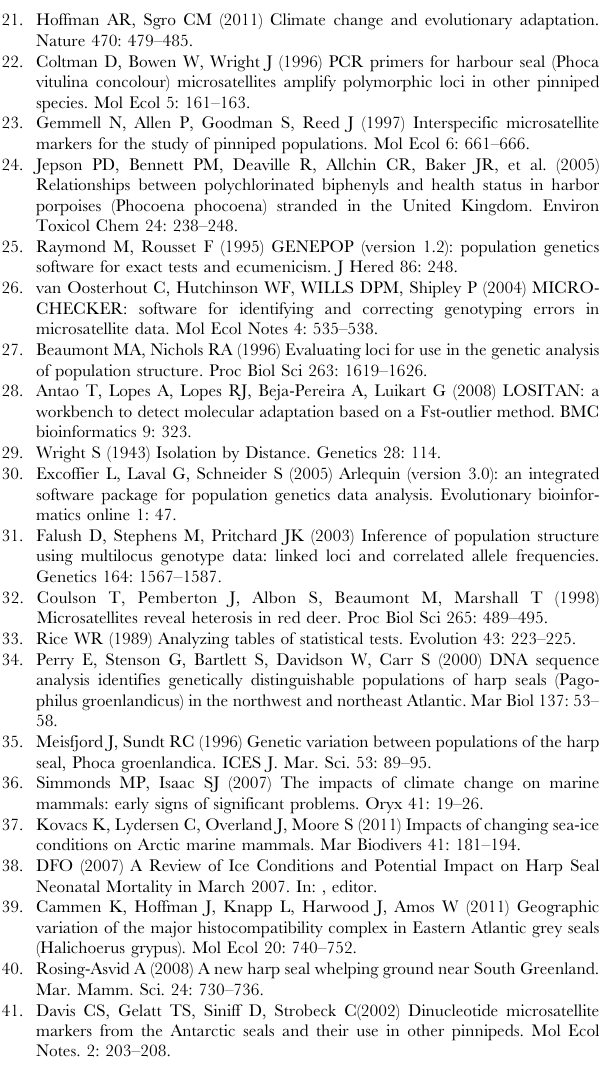
Table S1 Summary of microsatellite loci used in this study, including observed heterozygosity (1 st column) and P-value for Hardy-Weinberg Equilibrium tests (2 nd column) within each group of harp